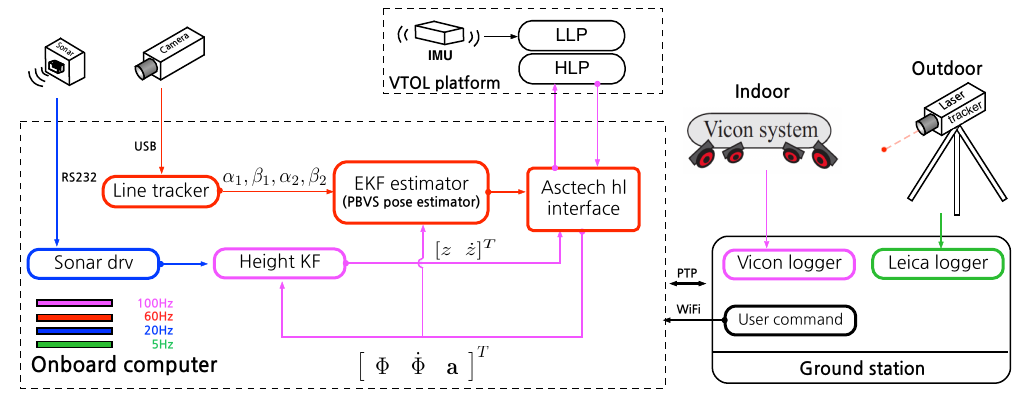
Figure 20. Sensor and software system diagram for PBVS experiments. Different colors denote different sampling rates. The software is implemented using ROS and all computation for a full update cycle happens within 16.6 ms (60 Hz ) on average. The line tracker utilizes 55% of the CPU. The Extended Kalman Filter (EKF) includes line model and Jacobian calculations and these steps take 6 µ s and 30 µ s respectively. Note that only one ground truth source is used at time. The Vicon system is used for indoor ground truth while the Leica laser tracker is used outdoors.